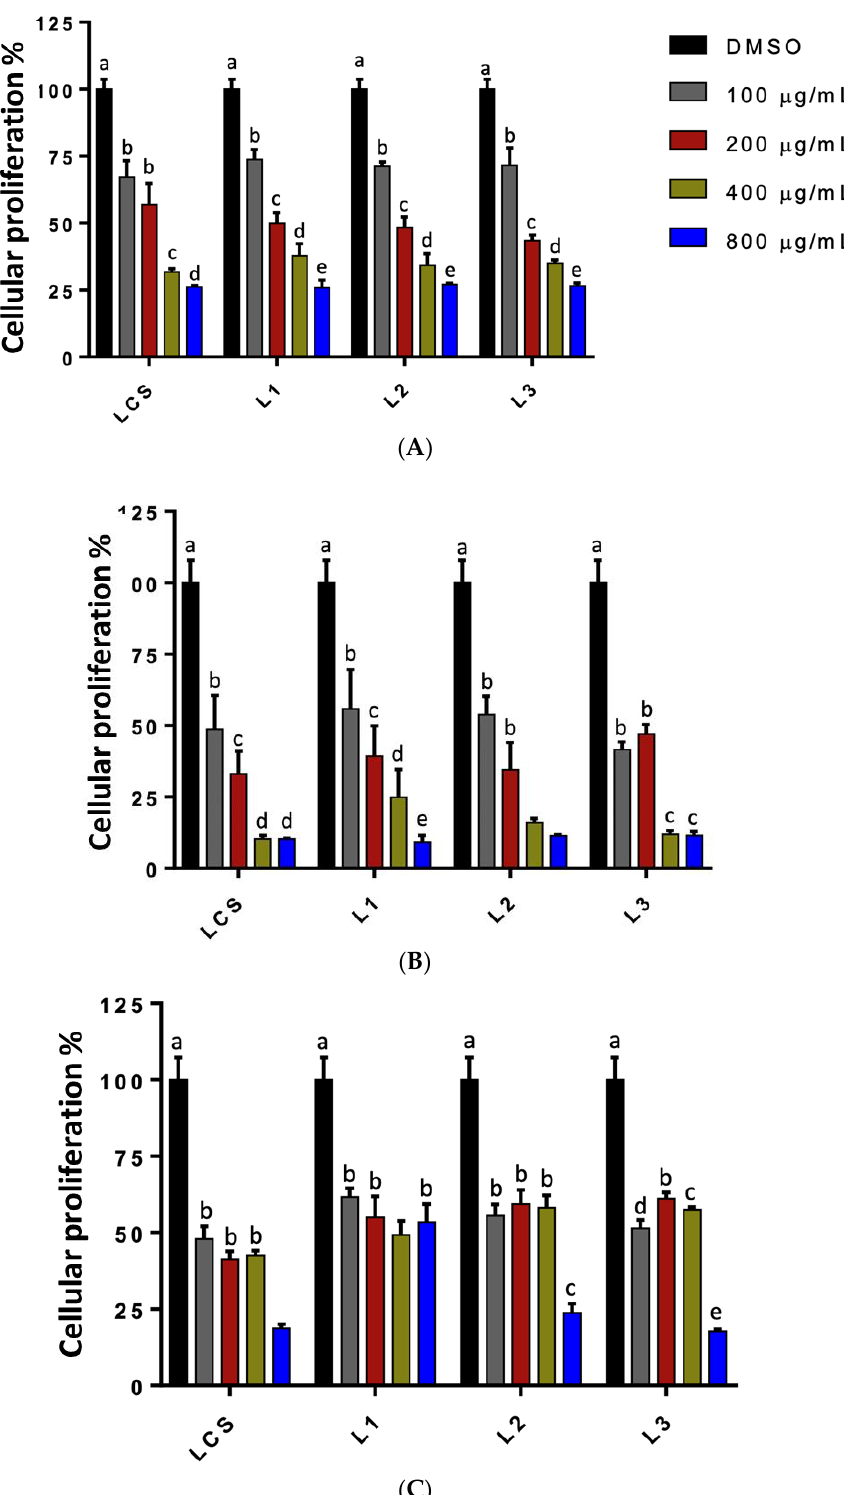
Figure 7. Antiproliferative activity on the cancer cell lines ( A ) HeLa, ( B ) PC-3, and ( C ) on the normal cell line normal cell L-929 of the sorghum lignin extracts without treatment (LCS) and with the different treatments (L1). Lignin treatment time/amplitude — 0/20; (L2) Lignin treatment time/amplitude — 10/18; (L3) Lignin treatment time/amplitude — 10/14. Samples were used in concentrations ranging from 0 – 800 µg/mL. The control was DMSO solvent. The data are from three independent experiments. Mean ± standard deviation. Different letters indicate significant difference ( p < 0.05).